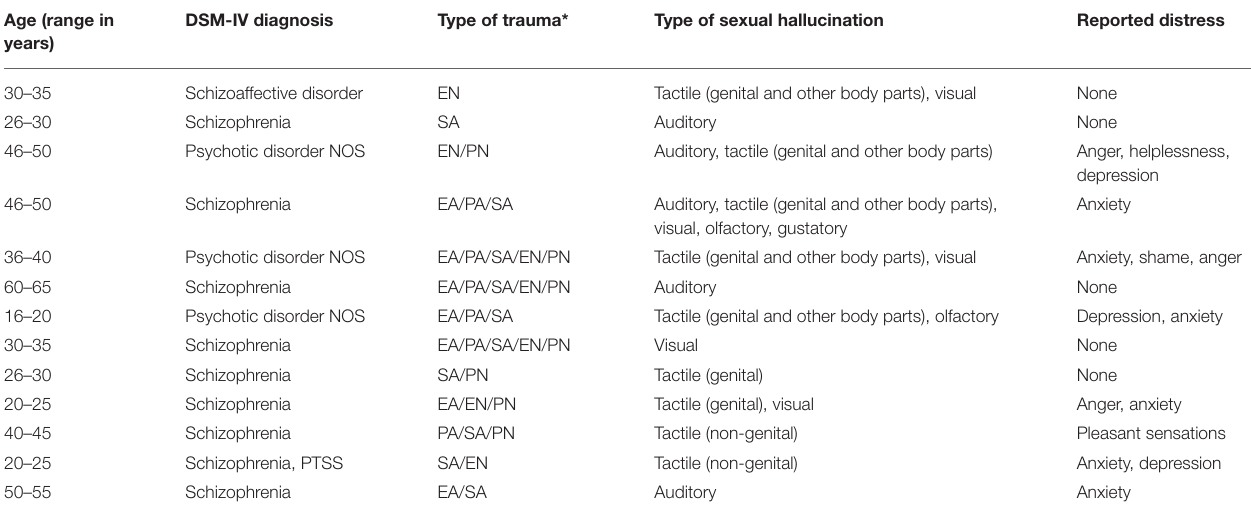
TABLE 1 | Overview of the 13 participants experiencing sexual